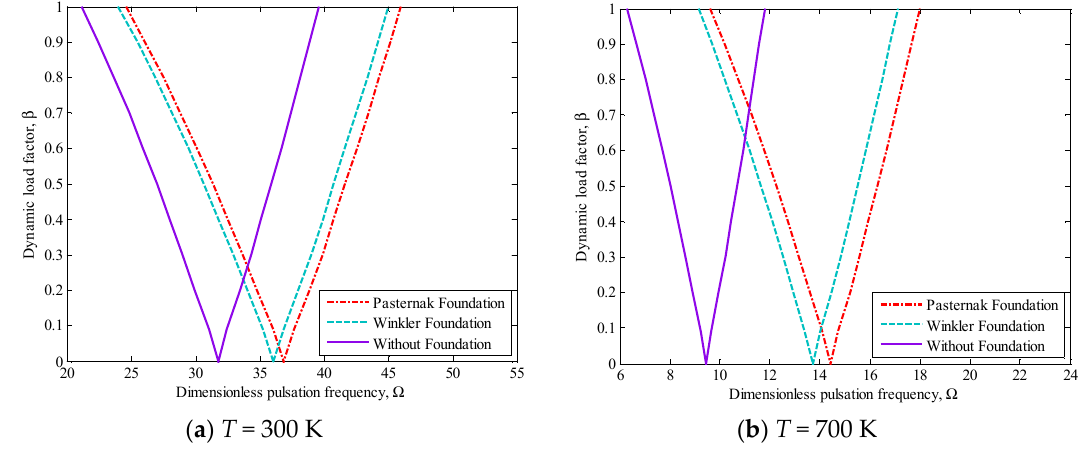
Figure 4. Effect of the elastomeric foundation on the DIR of the SLGS.